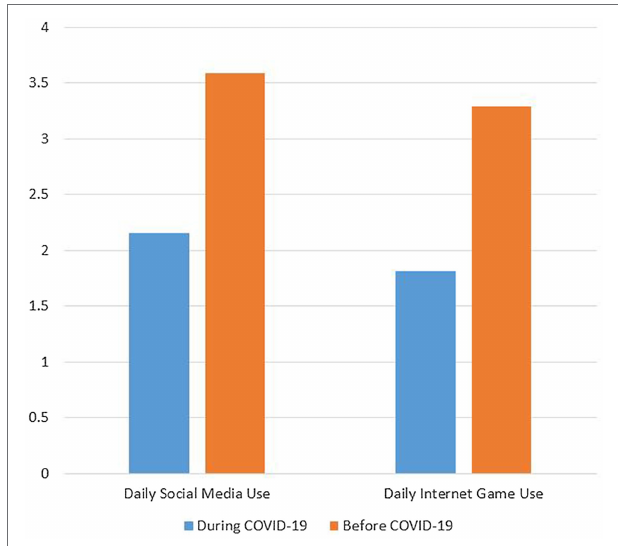
FIGURE 2 | Daily use of social media and Internet game before and during COVID-19